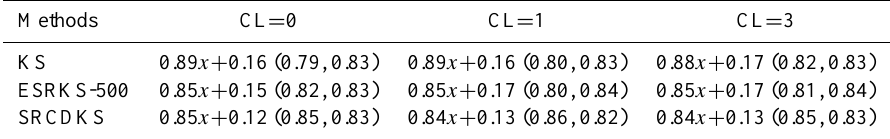
Table 2. Inversion results using different correlation lengths (CL) with the lag length equals to 7. All statistics are tested for statistical significance with p < 0 . 001. The first value in the brackets is the root mean square error of the inversion; the second value is the R 2 value of the linear regression. The regressions are the posterior fluxes against the true fluxes. Interval constraints are applied using the methods described in the text. The SRCDKS is implemented with the reduced set of sigma points chosen using the PCA method.